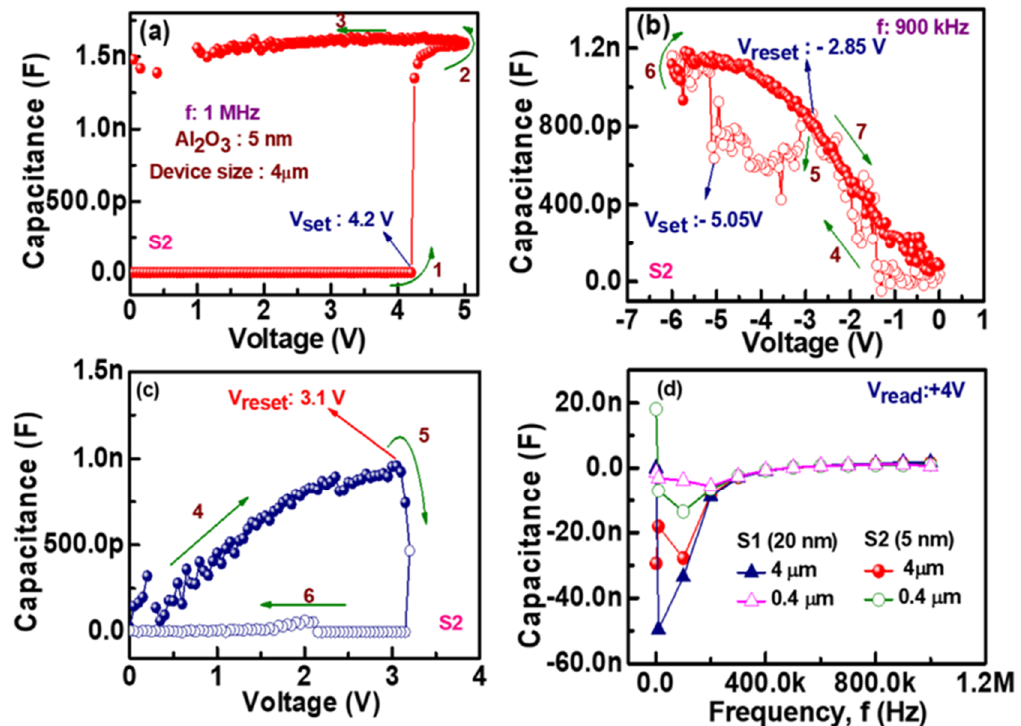
Figure 5. C-V characteristics by applying ( a ) positive sweep voltage of 4 V and ( b ) negative sweep voltage of −6 V for the S2 devices. The device size is 4 × 4 µm2. ( c ) Interpretation of unipolar switching by C-V characteristics. ( d ) Frequency dependent C-V response of the S1 (20 nm) and S2 (5 nm) devices with sizes of 0.4 × 0.4 µm2 and 4 × 4 µm2.